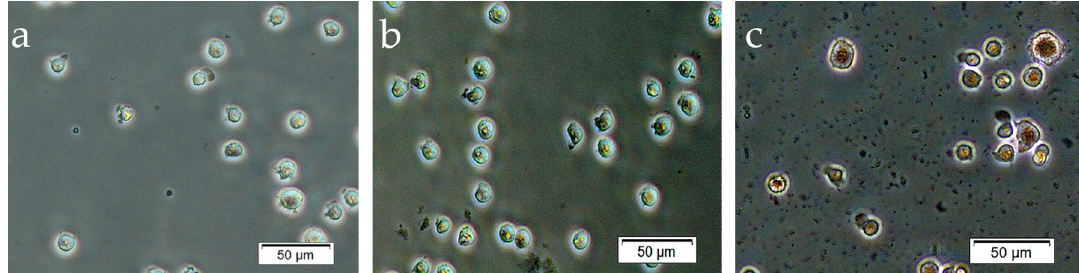
Figure 6. Adherent Jurkat T cells in 14 days of culture either before ( a ) or after alizarin red S ( b , c ) staining. ( a ) Unstained cells; ( b ) weakly stained nuclei of cells in the control culture without microarc CaP-coated titanium samples; ( c ) clearly stained nuclei of cells in contact with microarc CaP-coated titanium samples.